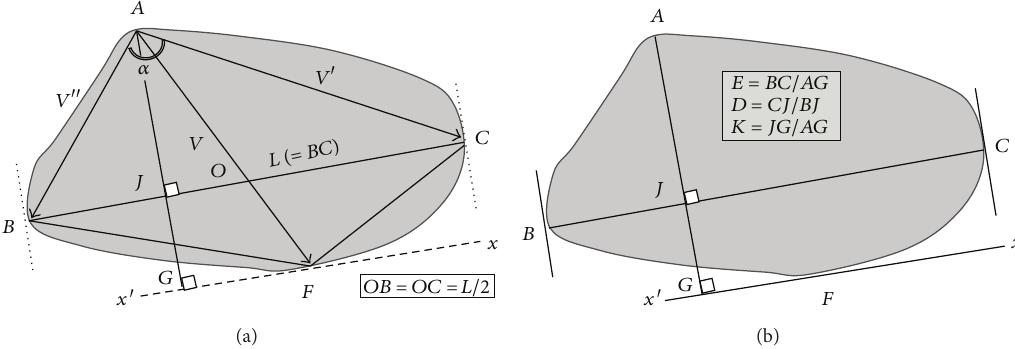
Figure 1: Definition of two alternative sets of descriptors of the shell outline: (a) the three growth-based parameters: apical angle 𝛼 (= B ˆAC ); differential growth index 𝜌 = 𝑉/(1/2)(𝑉 󸀠 + 𝑉 󸀠󸀠 ) ; dissymmetric growth index 𝛿 = 𝑉 󸀠 /𝑉 󸀠󸀠 ; (b) the three functionally relevant parameters: elongation 𝐸 , dissymmetry 𝐷 , and ventral convexity 𝐾